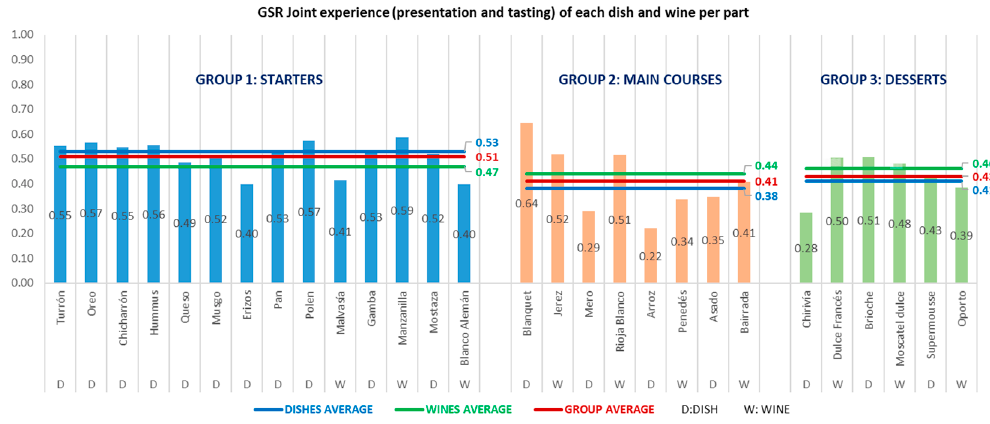
Figure 7. Presentation and tasting global GSR analysis for each dish and wine. Groups for the three phases. Source: Original work from the authors.